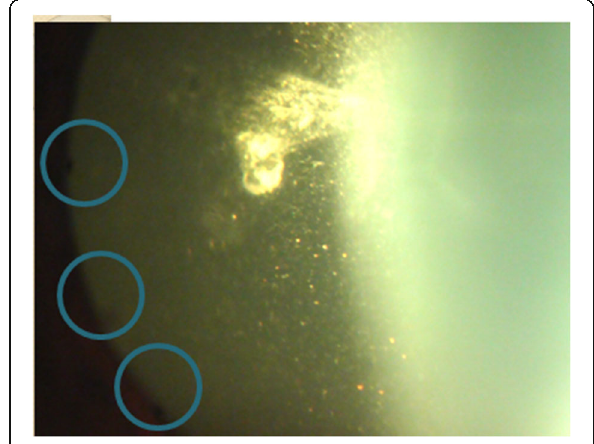
Fig. 3 Band-like hyperechogenic structure extending from the vitreous base towards the posterior hyaloid surface and optic nerve